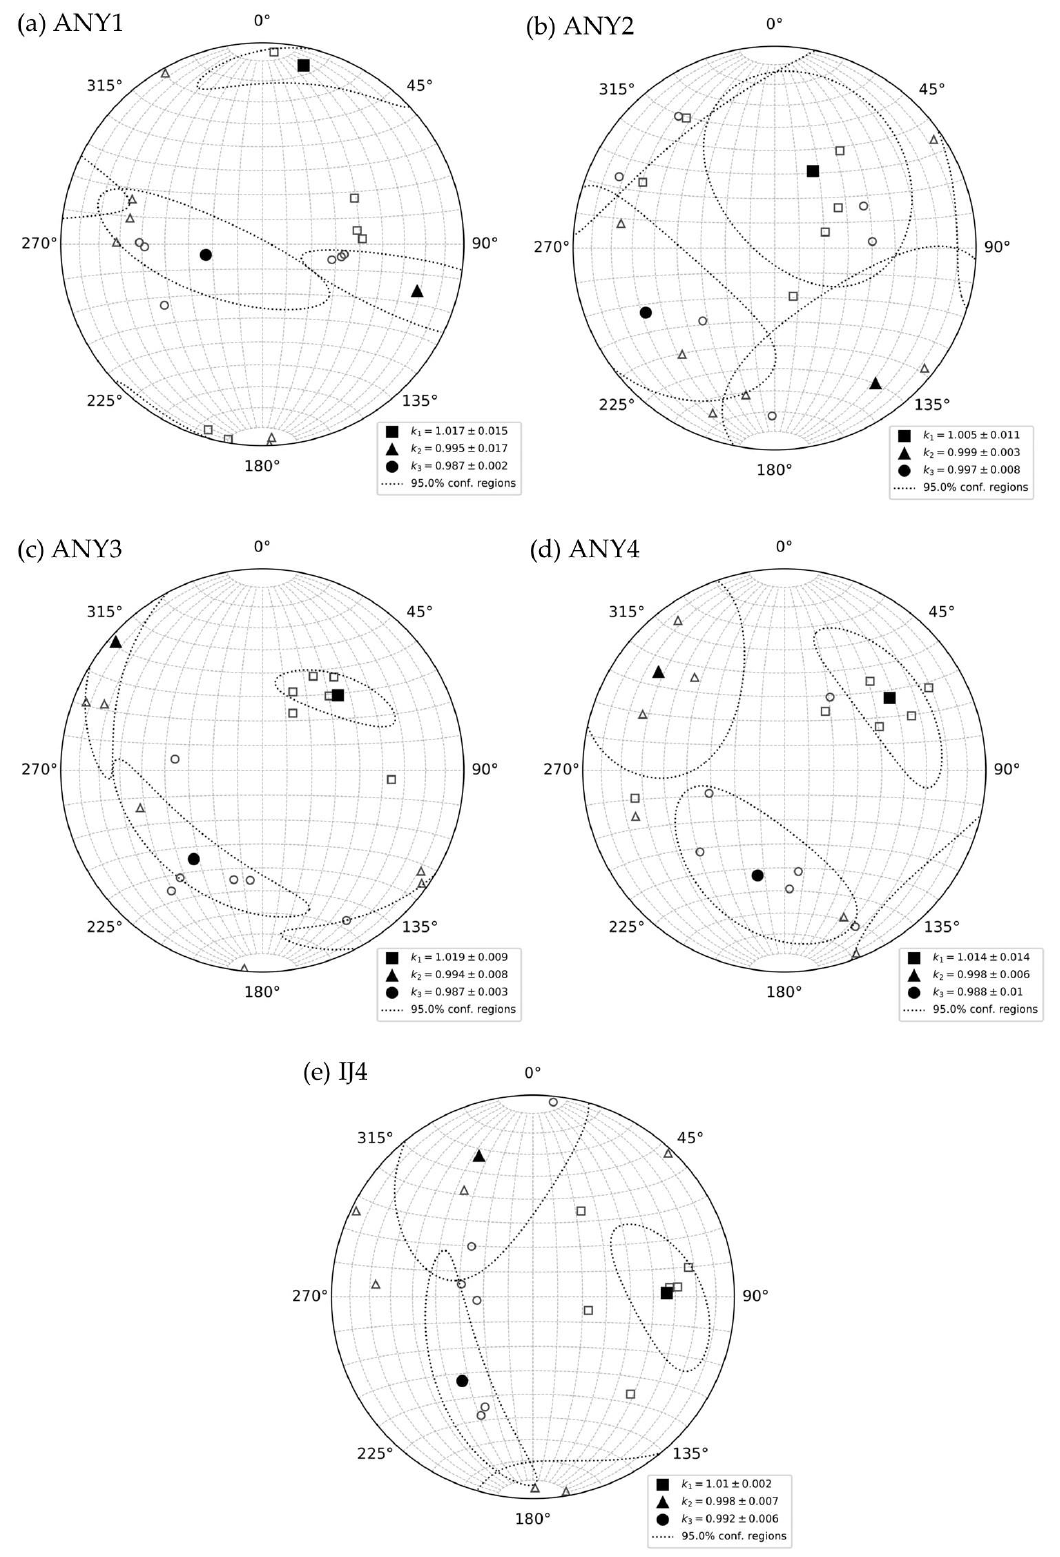
Figure 3. Lower hemisphere projection on equal area stereograph of ( a ) ANY1; ( b ) ANY2; ( c ) ANY3; ( d ) ANY4 and ( e ) IJ4 that contain all the principal susceptibilities from six core specimens. Large filled symbols represent the mean vector of each corresponding axis. Circles show the 95% area of confidence. K 1 = maximum susceptibility, K 2 = intermediate susceptibility, and K 3 = minimum susceptibility.